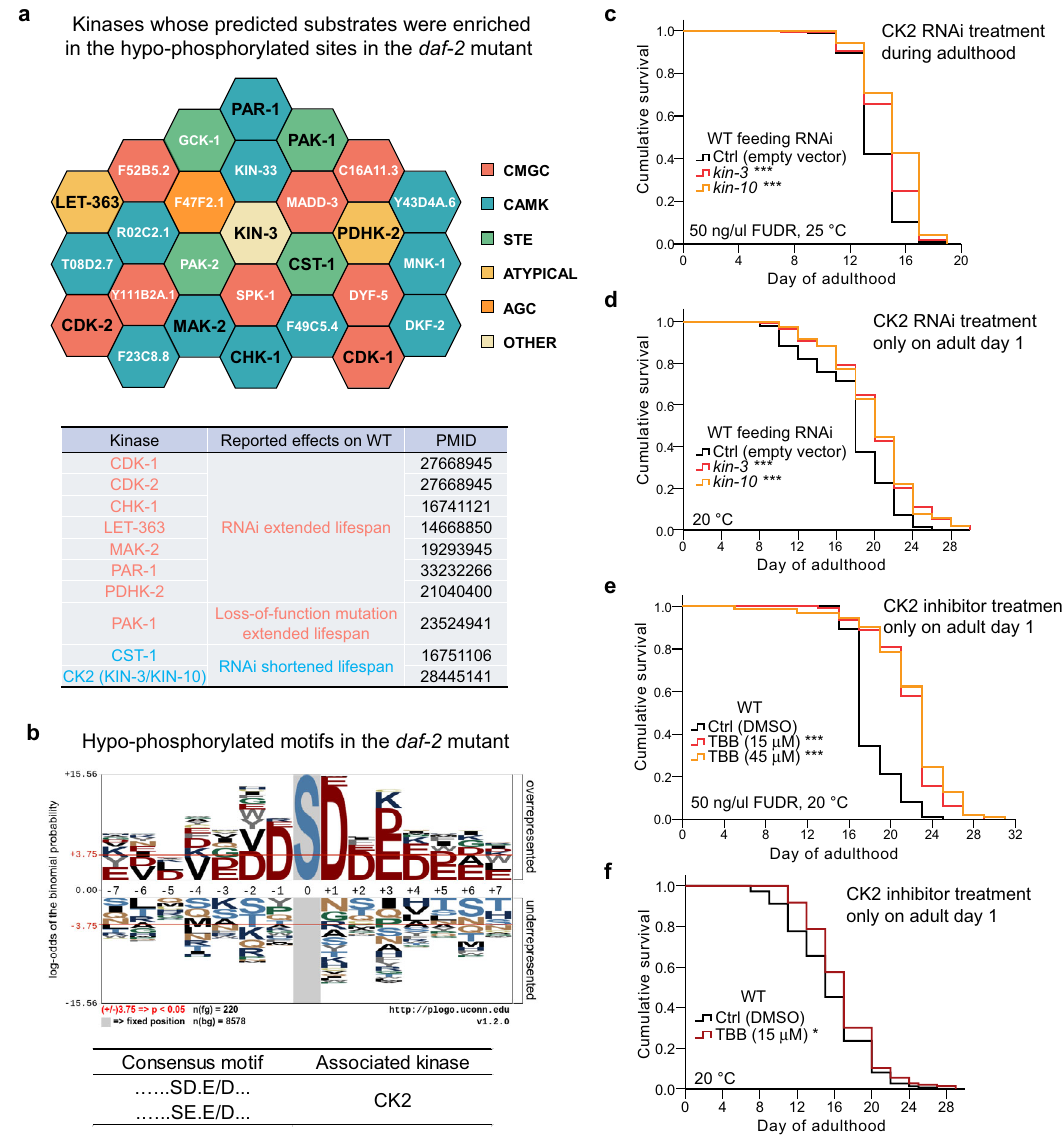
Fig. 6 Inhibition of CK2 extends the worm lifespan. a Honeycomb diagram displays iGPS-predicted kinases whose target motifs were signi fi cantly (one- sided hypergeometric test, p < 0.05) enriched among the hypo-phosphorylated sites in the daf-2 mutant. Kinase groups are depicted in different colors. Bold black highlights the kinases reported to regulate lifespan. See statistics in Source data. b CK2 consensus motifs overrepresented in the hypo- phosphorylated peptides in the daf-2 mutant. An online service pLogo 52 (https://plogo.uconn.edu/) was used to visualize the statistical signi fi cance of the frequently occurred motifs among the hypo-phosphorylated sequences in daf-2 . The phosphosites were fi xed at position 0. All quanti fi ed phosphopeptides were taken as the background sequences. The red horizontal lines correspond to p = 0.05. c CK2 knockdown in adulthood signi fi cantly extended the lifespan of WT worms. kin-3 or kin-10 encodes the catalytic or regulatory subunit of CK2, respectively. Lifespan assays were performed at 25 °C, with 50 ng/ μ l FUdR supplied in plates. d RNAi of kin-3 or kin-10 from adult day 1 for 24 h signi fi cantly extended the lifespan of WT worms. Lifespan assays were performed at 20 °C without FUdR. e Feeding WT with TBB, the highly selective inhibitor of CK2, from adult day 1 for 24 h signi fi cantly extended the worm lifespan. Lifespan assays were performed at 20 °C, with 50 ng/ μ l FUdR supplied in plates. f TBB treatment from adult day 1 for 24 h signi fi cantly extended the lifespan of C. elegans . Lifespan assays were performed at 20 °C without FUdR. * p < 0.05, *** p < 0.001, two-sided log-rank test, n > 70 worms per strain. See survival statistics in Supplementary Dataset Phosphoprotein sampling . Worms were synchronized by egg bleaching and overnight incubation in M9 buffer. The synchronized L1 larvae were fed with OP50 at 20 °C, harvested at adult day 1, and subjected as unlabeled ( 14 N) C. elegans samples. The 15 N-labeled C. elegans reference sample was prepared by culturing WT for generations on 15 N-labeled MG1655 at 20°C and harvesting in mixed C18 reversed-phase HPLC column (10 × 250 mm, 5µm, Welch Materials) using an stages. Agilent 1200 Series HPLC instrument 19 . Solvent A (2% acetonitrile (ACN), 10mM The 14 N and 15 N worms mixed at ratio 1:1 by volume were suspended in lysis buffer [2× RIPA buffer, 2× EDTA-free proteinase inhibitors cocktail (Roche), and 2× PhosSTOP EASYpack (Roche)], homogenized in a FastPrep ® -24 instrument (MP Biomedicals), and spun at >20,817× g for 30 min. The supernatants were